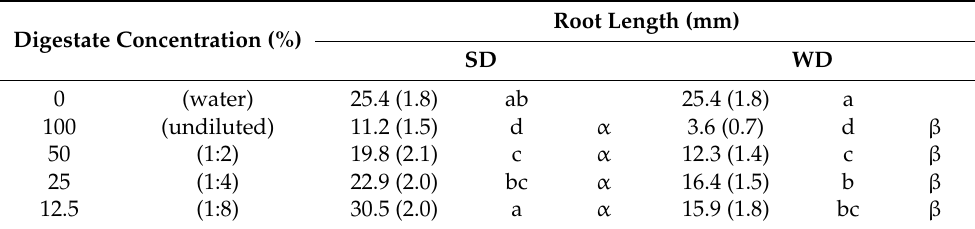
Table 2. Root length (mm) of maize seedlings after 1 week of incubation under different digestate concentrations (means followed by standard error in brackets). Different Latin letters within a column indicate statistically significant differences between digestate concentrations at p ≤ 0.05 (Fisher LSD test); different Greek letters within a row indicate statistically significant differences between digestate types at p ≤ 0.05 (Fisher LSD